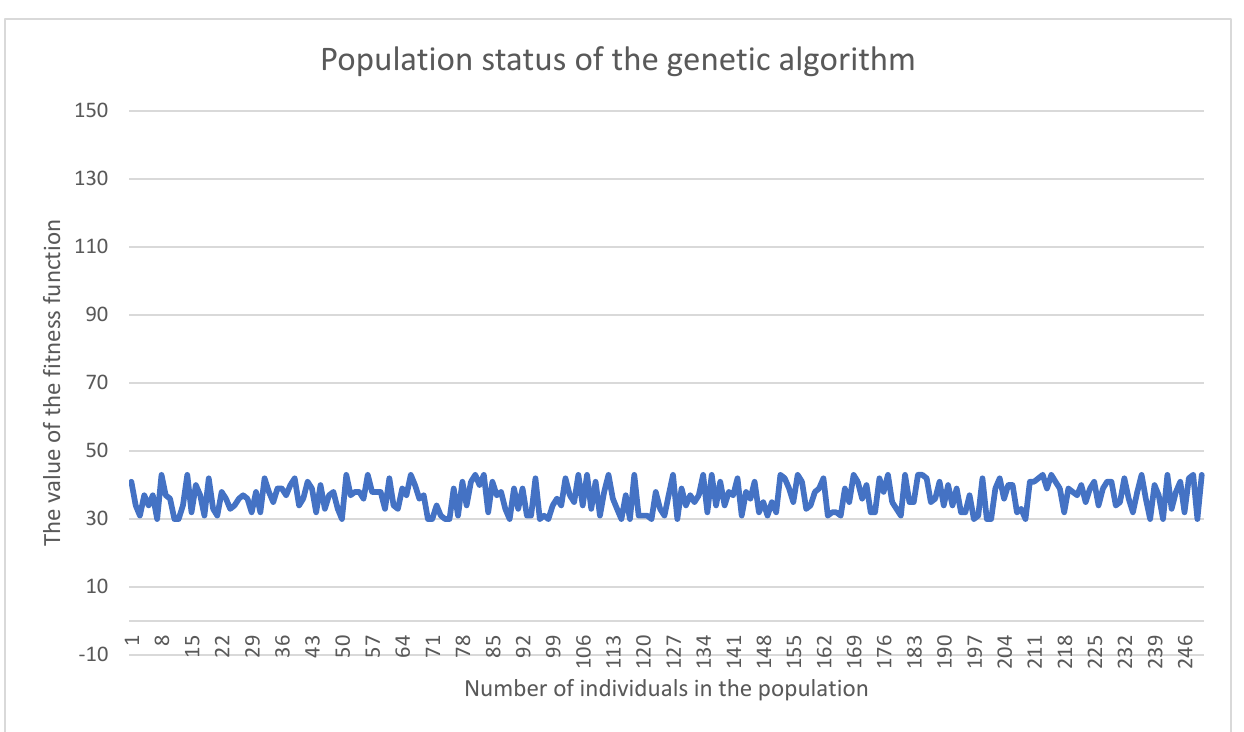
Figure 7. Example of input data for training an artificial neural network. As a result of the training, the values of the synapse weight coefficients were obtained, which were used in modeling an artificial neural network using Petri net theory.